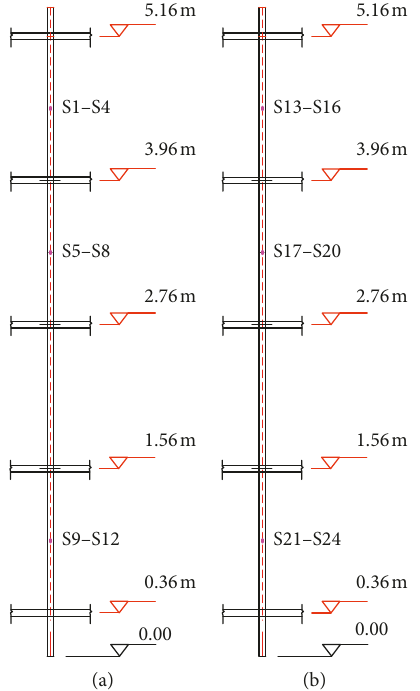
Figure 7: Layout of displacement sensors in Models 4 and 5. (a) A- 3 rod. (b) C-6 rod.